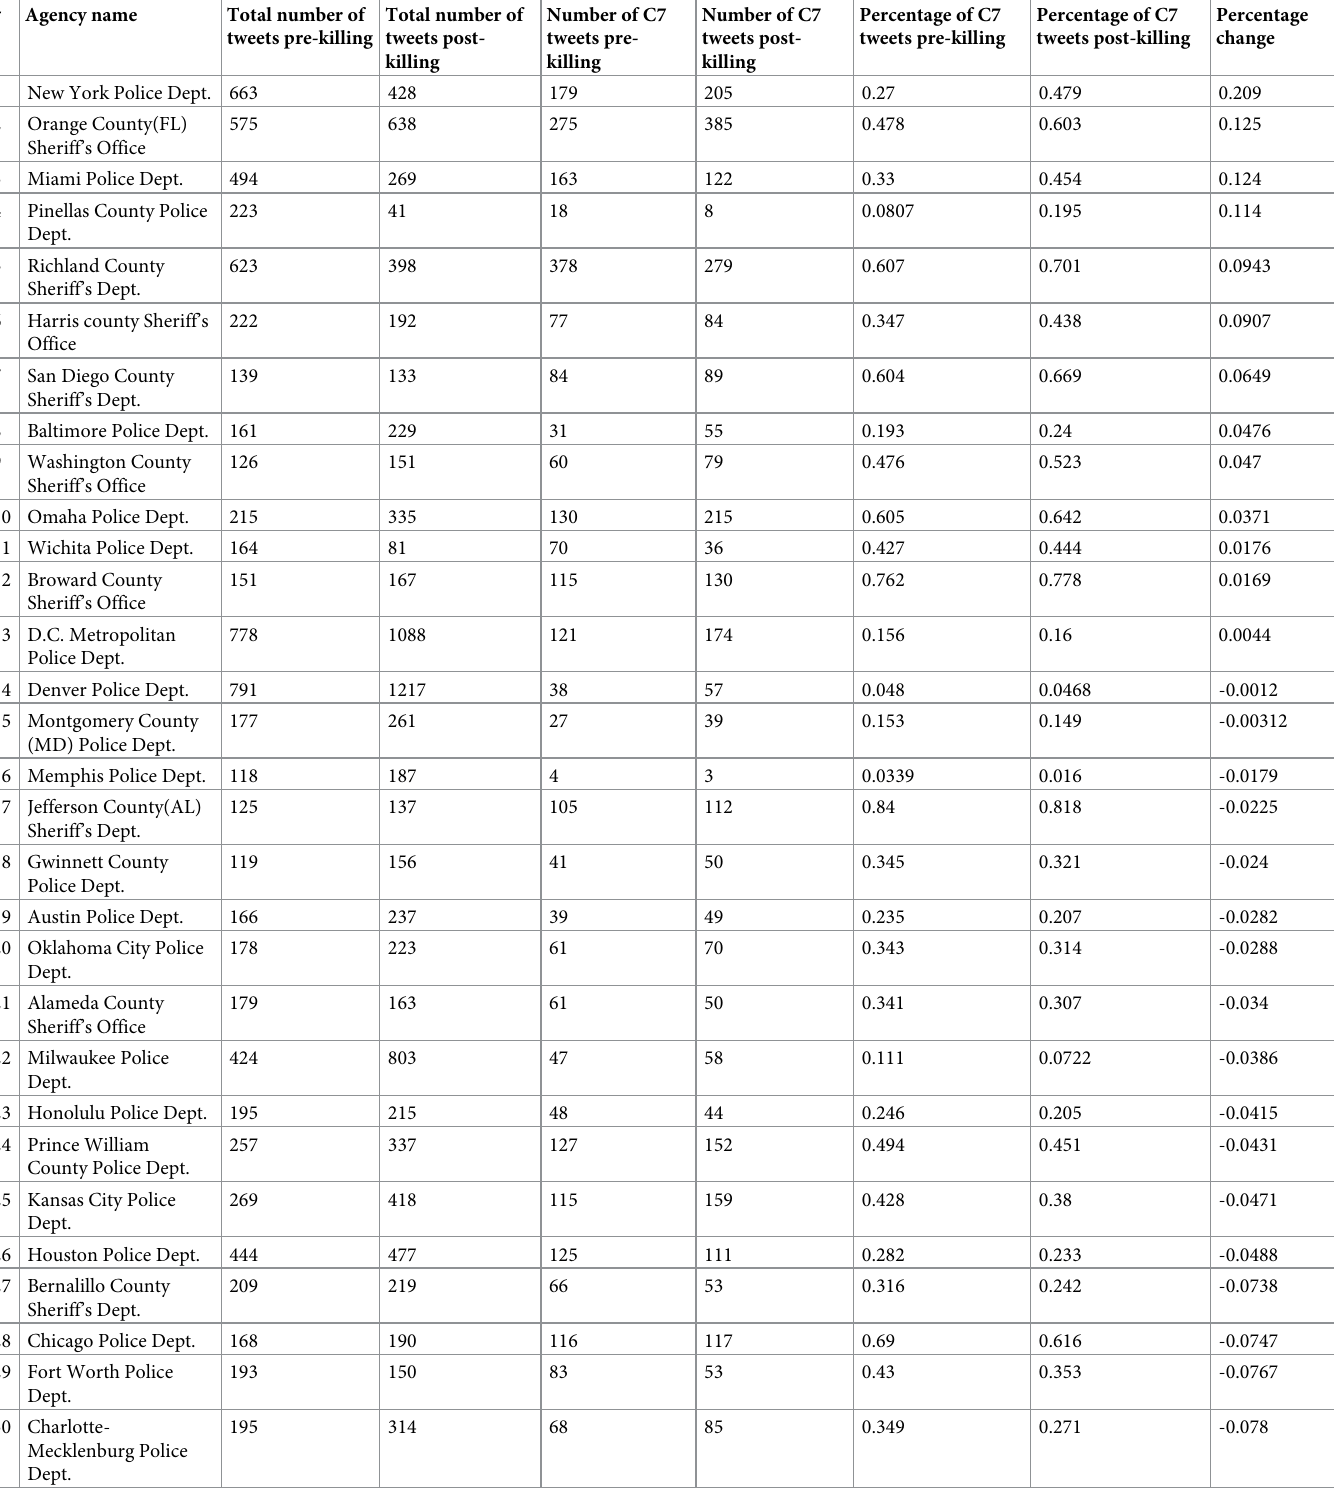
Table 11. Agencies (in the higher-use group) ranked by the increase in posting category 7 (community engagement and outreach) tweets before and after the killing. # Agency